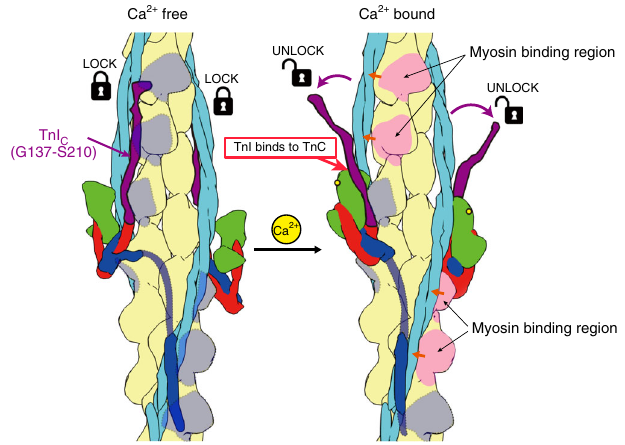
Fig. 7 Schematic diagram of the Ca 2 + regulatory mechanism of muscle contraction. The structural changes between Ca 2 + free and bound states are shown. In the Ca 2 + free state, TnI C (dark purple) binds to actin (beige) and Tm (light blue) above the Tn core (green, red and blue), covering the myosin head binding sites. But entire TnI C dissociates from them upon Ca 2 + binding to TnC N by the binding of a short N-terminal portion of TnI C to TnC N . This causes Tm to move around on the actin fi lament surface (short orange arrows) together with TnT N near the head-to-tail junction of Tm, thereby exposing some of the myosin head binding sites shaded in light gray to allow actin – myosin interactions (light